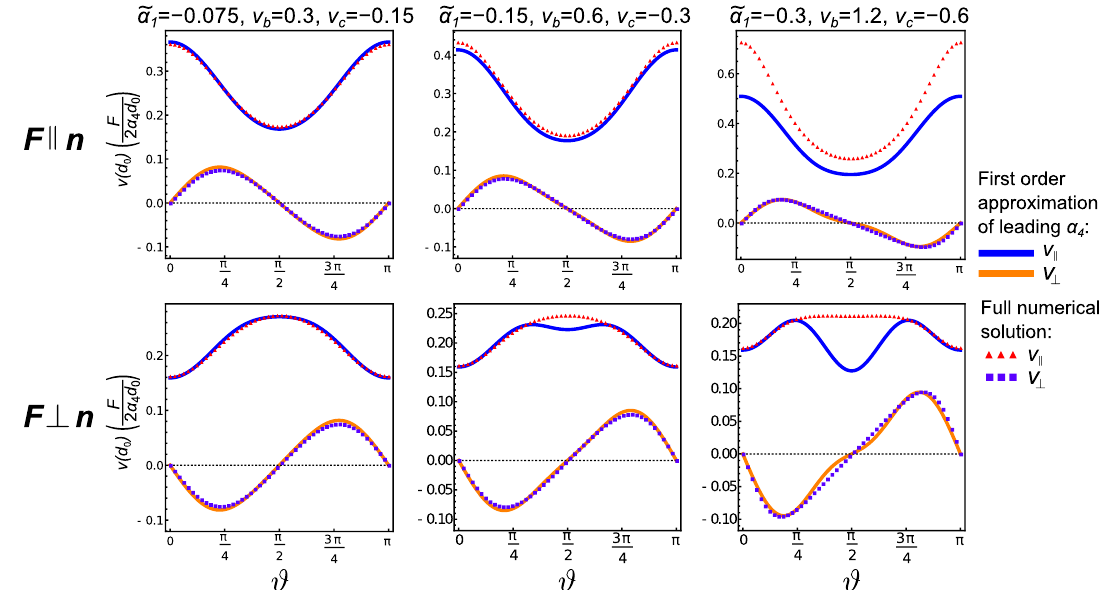
Figure 7. Evaluation of small α i / α 4 expansion assumption. Results for the point force along the director (first row) and perpendicular to the director (second row) obtained through the nematic Green function in Equations (24)–(29) are compared to the results obtained by numerical inverse Fourier transform of Equations (10)–(13) at distance d 0 from the point of force origin. The comparison is performed for the values of Leslie coefficients used throughout this article (middle column), values twice as small (first column) and twice as large (third